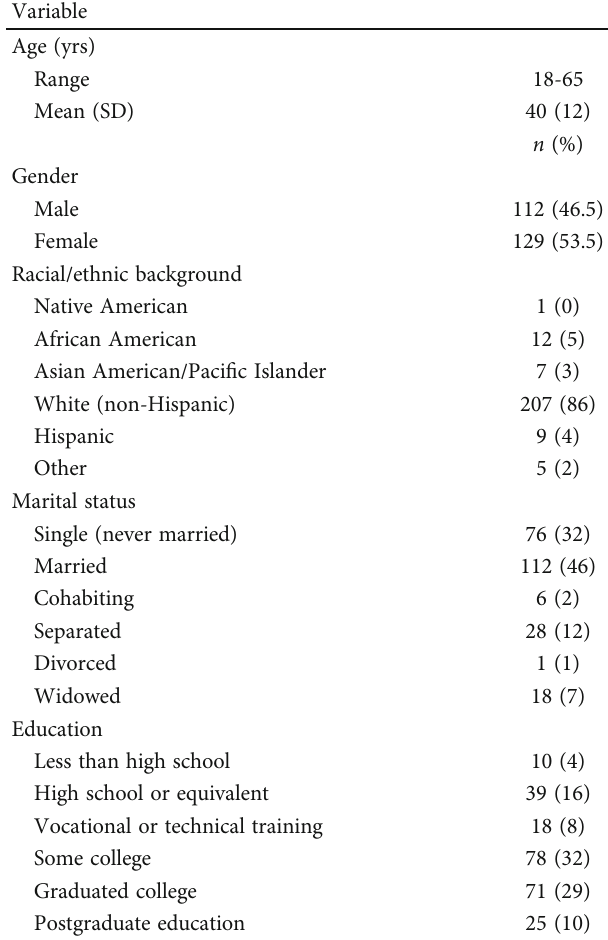
Table 1: Demographic characteristics of the participants, n = 241